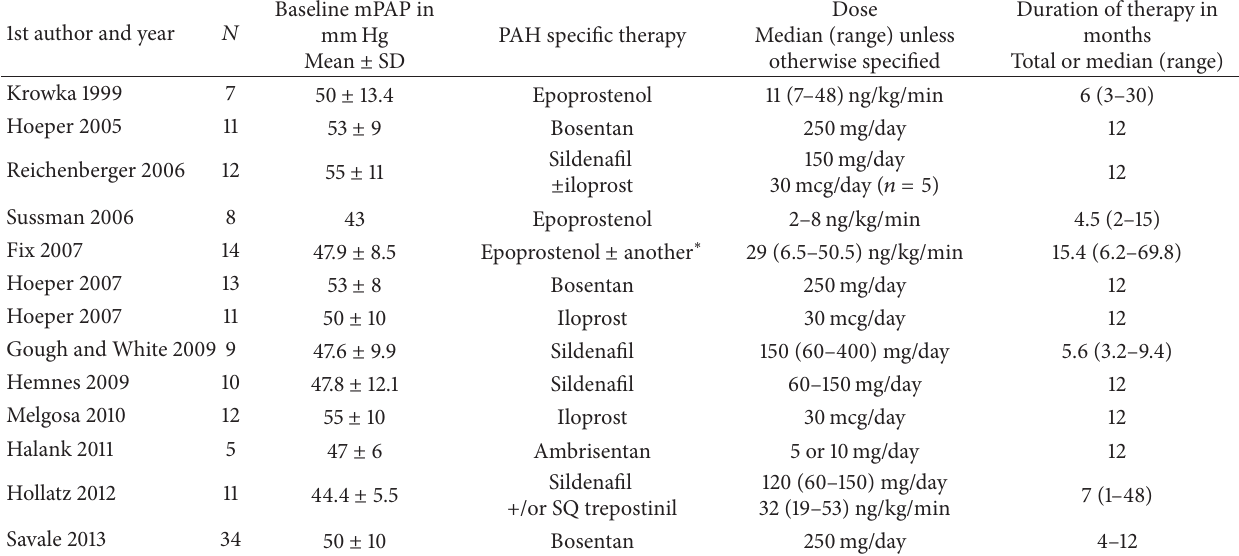
Table 2: Regimens of pulmonary arterial hypertension specific therapy used in the included studies